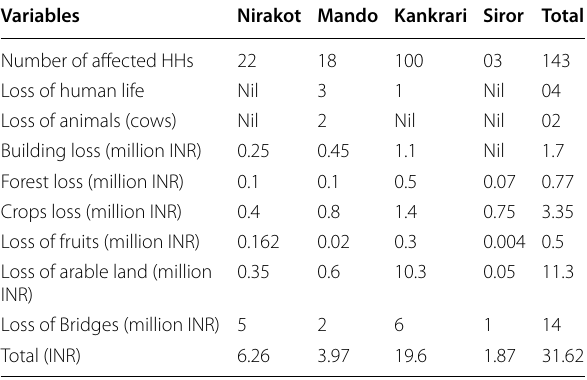
Table 4 Economic impact of cloudburst-triggered debris flow and flash flood. Source : By authors